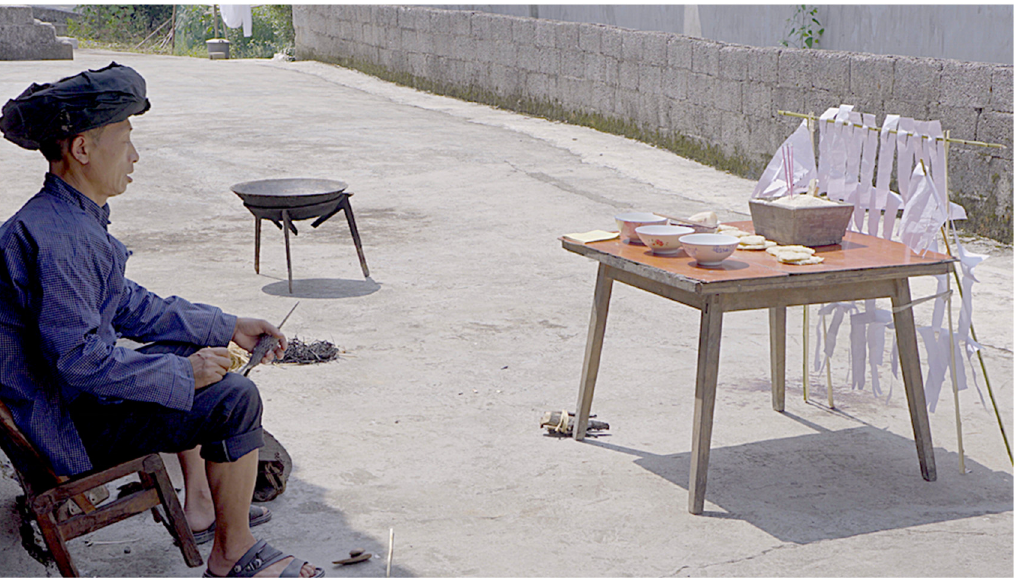
Figure 8. Badai Yang during the first part of the tali tree ritual. (Photo: Thomas Riccio).